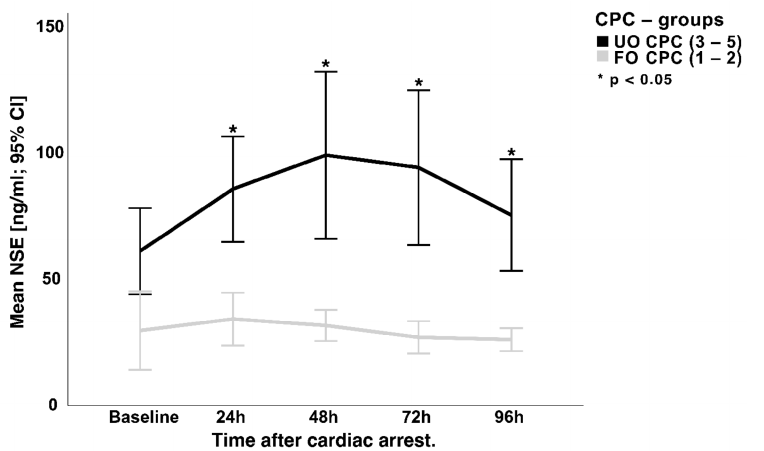
Figure 3. Mean NSE levels compared between the two CPC outcome groups. CPC = cerebral performance category scale; NSE = neuron-specific enolase; p = level of significance; CI = confi- dence interval.